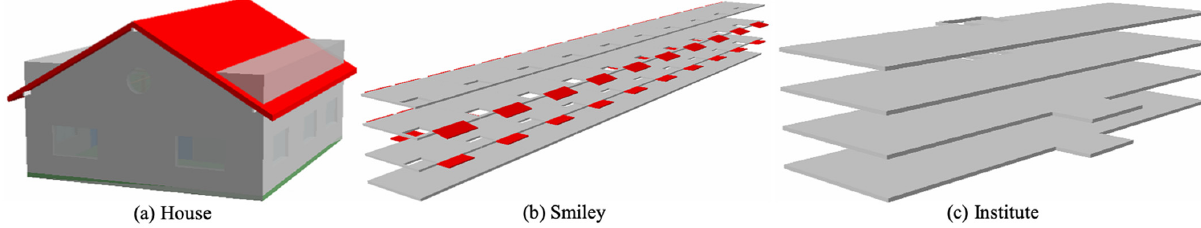
Figure 15. ( a ) Incorrect s-LoD1 model for house, ( b ) semantically differentiated slabs in Smiley building model, and ( c ) not semantically differentiated slabs in institute building model.